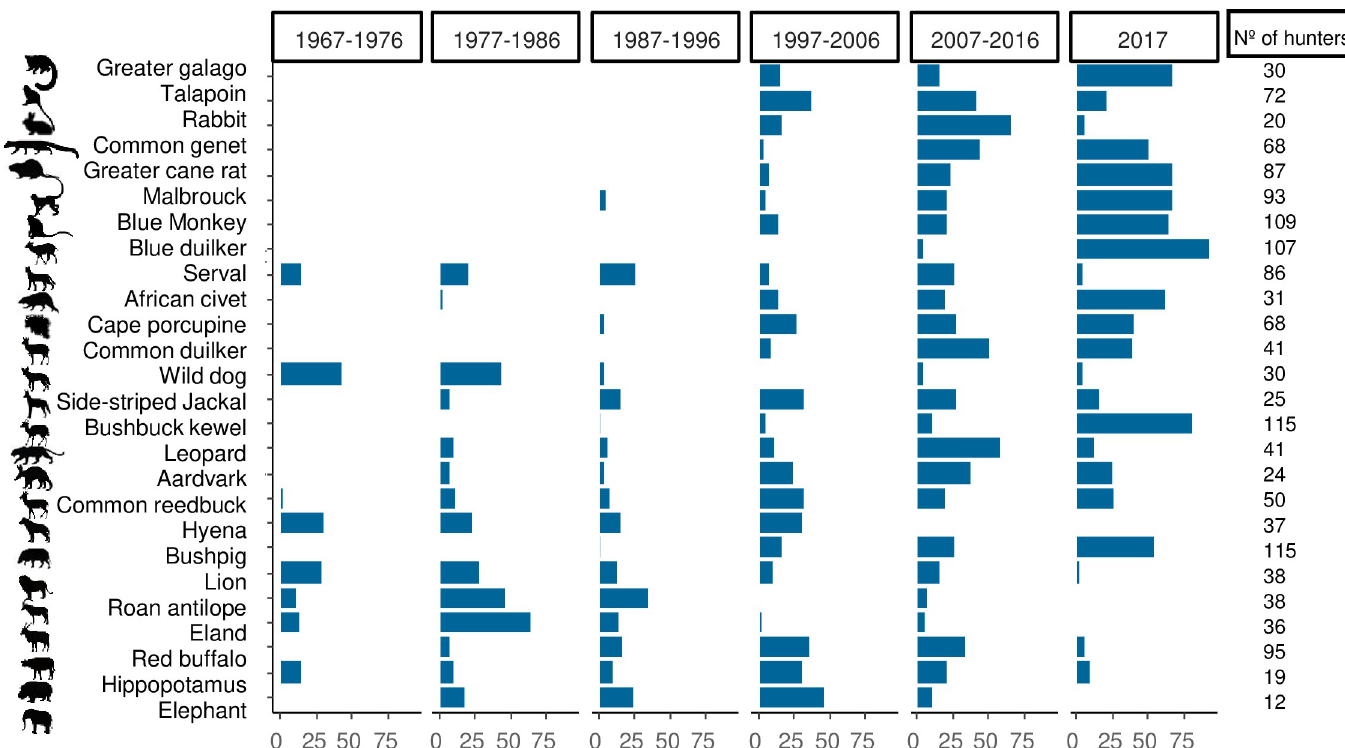
Fig 2. Records of the most recent year in which each interviewee had killed a mammal species. Data are presented in 10-year increments for historical (1967–2016) and modern periods (2017). Response rates were calculate from the number of hunters reporting killing each species. Species are denoted by their English names and ordered top to bottom from the smallest to the largest